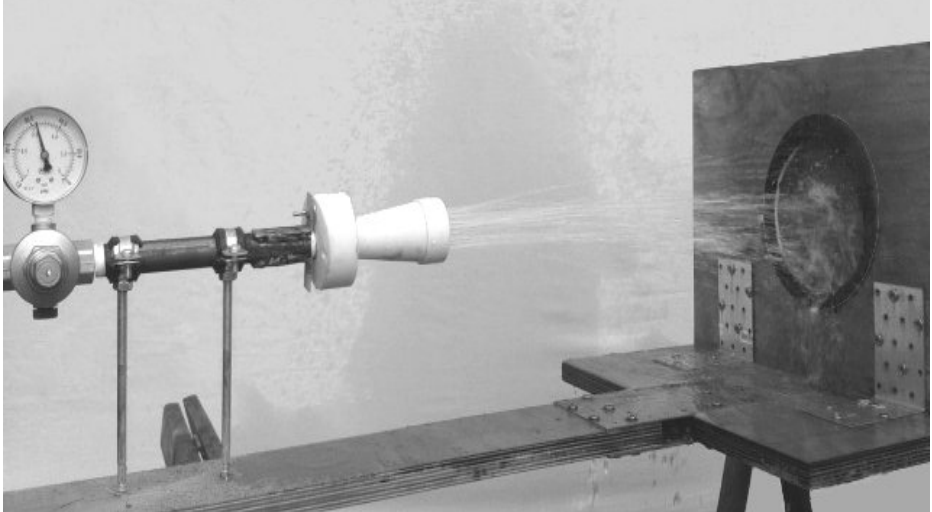
Figure 5. Measurement of erosion under the influence of pressurized water jet.